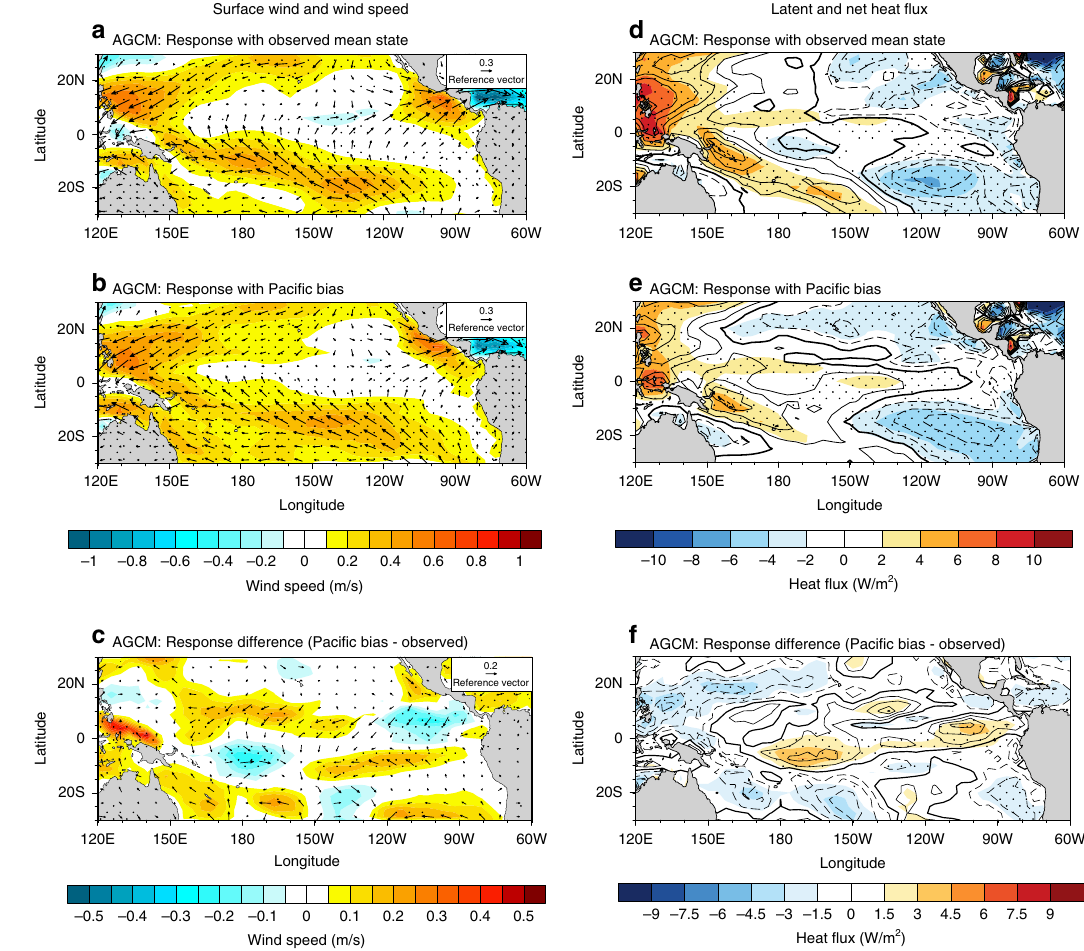
Fig. 4 Surface wind and heat fl ux response in atmosphere-only simulations. a , b Surface wind (vectors; m s − 1 ) and wind speed (shading; m s − 1 ) response to the Atlantic warming forcing in the observed mean state and Paci fi c bias atmosphere-only (AGCM) simulations, respectively. c The response differences between ( b ) and ( a ). d – f As in ( a – c ), but for the latent heat fl ux (shading; W m − 2 , downward is positive) and downward net heat fl ux (contour; W m − 2 ). The solid (dashed) contour indicates positive (negative) value for net heat fl ux, solid bold contour indicates 0. Contour interval is 2 and 1.5 W m − 2 in ( d , e ) and ( f ), respectively. Stippling indicates the wind speed ( a – c ) and the latent heat fl ux ( d – f ) response or response differences are statistically signi fi cant above the 90% con fi dence level. Note the red (blue) colour in ( d – f ) means ocean gains (loss) latent heat fl